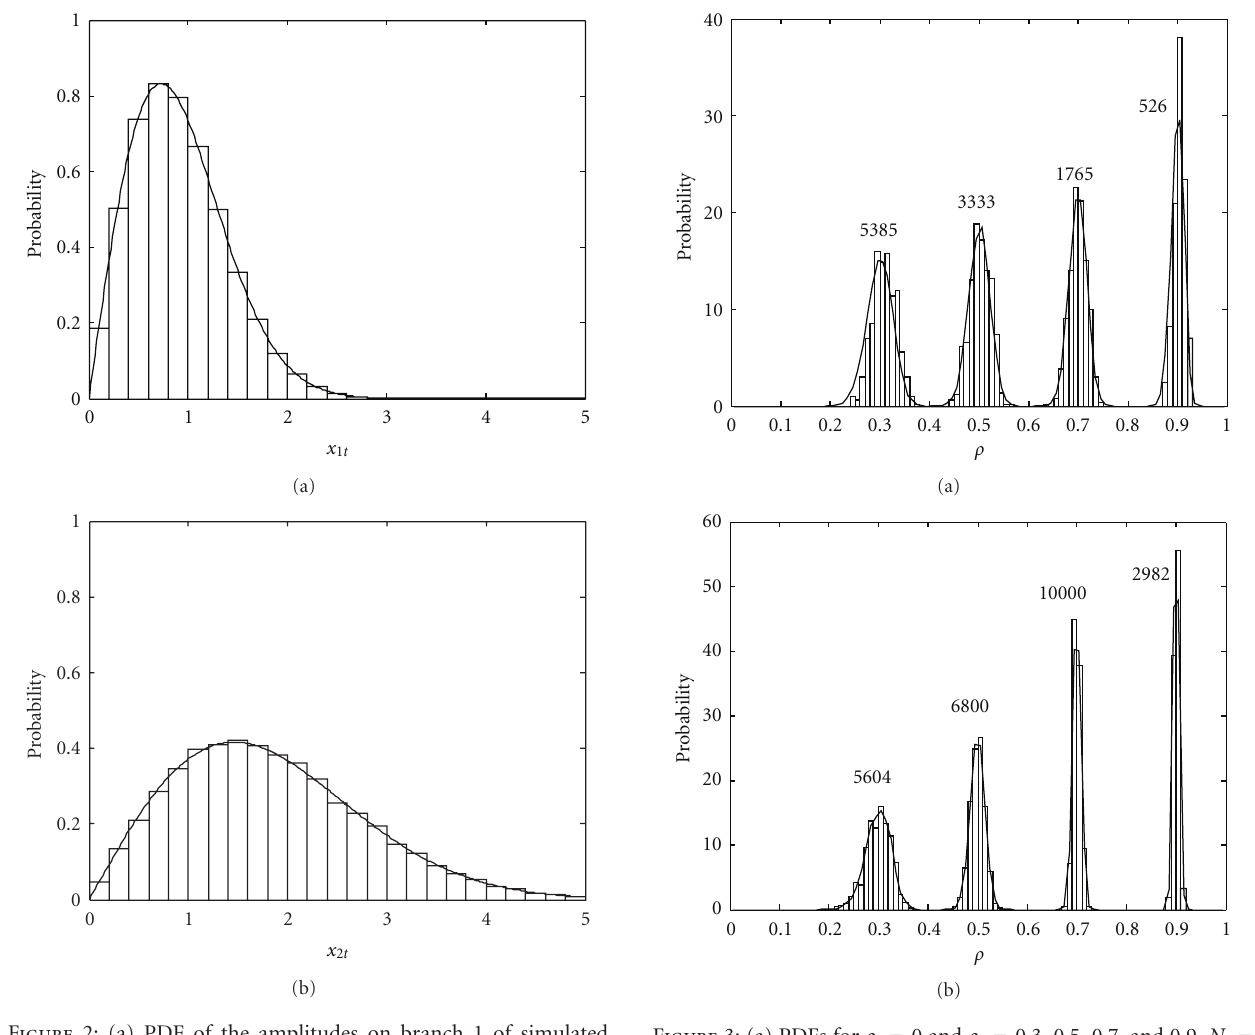
Figure 3: (a) PDFs for ρ i = 0 and ρ t = 0 . 3, 0.5, 0.7, and 0.9. N i = 10000 in all cases. Numbers next to the peaks are N t values. Histograms are the results of simulations with 500 realizations. Solid lines show spreads due to finite sequence length for the N t values at hand. (b) PDFs for ρ i = 0 . 7 and ρ t = 0 . 3, 0.5, 0.7, and 0.9. N i = 10000 in all cases. Numbers next to the peaks are N t values. Histograms are the results of simulations with 500 realizations. Solid lines show spreads due to finite sequence length for the N t values at